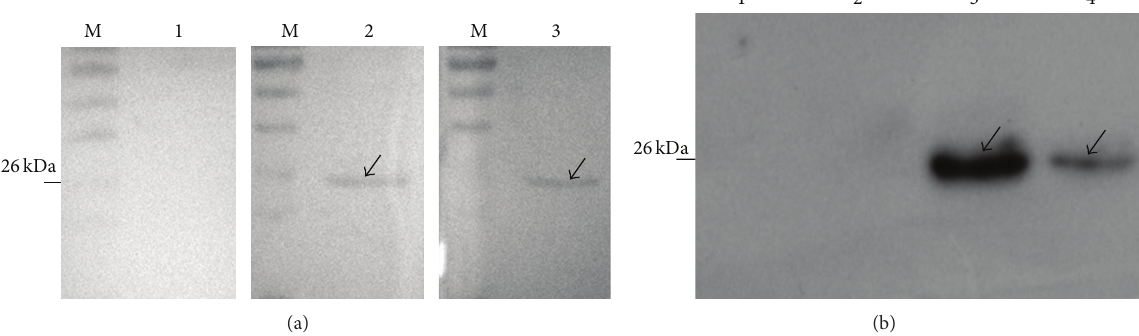
Figure 7: Western blot analysis of clone number 29. (a) 1: primary antibody: crude cell extract of pComb3 clone; 2: primary antibody: crude cell extract of number 29 clone; 3: primary antibody: mouse anti-His antibody; 1, 2, and 3: antigen: P-gp 21 protein; secondary antibody: ALP- labeled horse anti-mouse IgG antibody. (b) 1: Antigen: BSA; 2: antigen: 15kDa peptide; both 3 and 4: antigen: P-gp 21 protein; 1, 2, 3, and 4: primary antibody: purified Fab; secondary antibody: HRP-labeled goat anti-mouse IgG antibody.